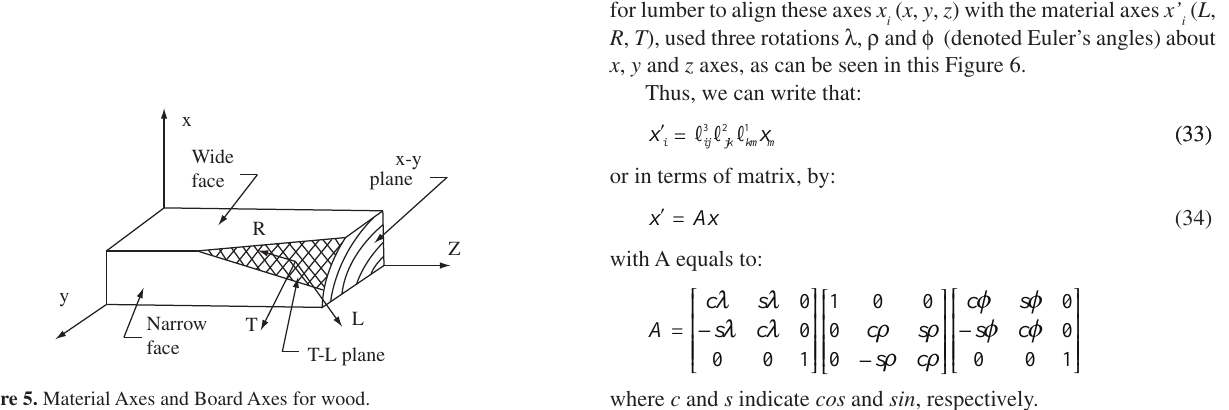
Table 1. Elastic constants of three species of wood ( E